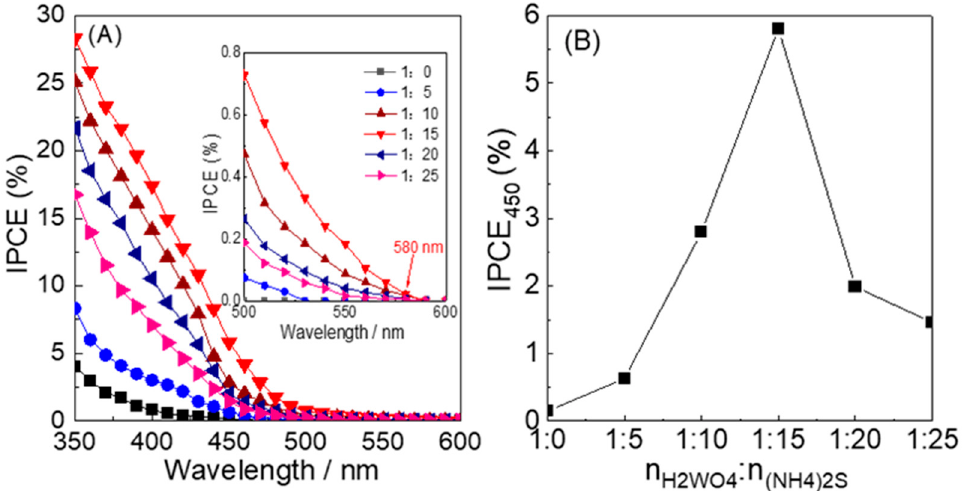
Figure 9. ( A ) Action spectra of IPCE of the (black) WO 3 − 0, (blue) WO 3 − 5, (wine) WO 3 − 10, (red) WO 3 − 15, (navy) WO 3 − 20, and (pink) WO 3 − 25 electrodes. ( B ) Plots of IPCE values at 450 nm versus the n W :n (NH4)2S ratio for the synthesized materials (WO 3 − 0, WO 3 − 5, WO 3 − 10, WO 3 − 15, WO 3 − 20, and WO 3 − 25).